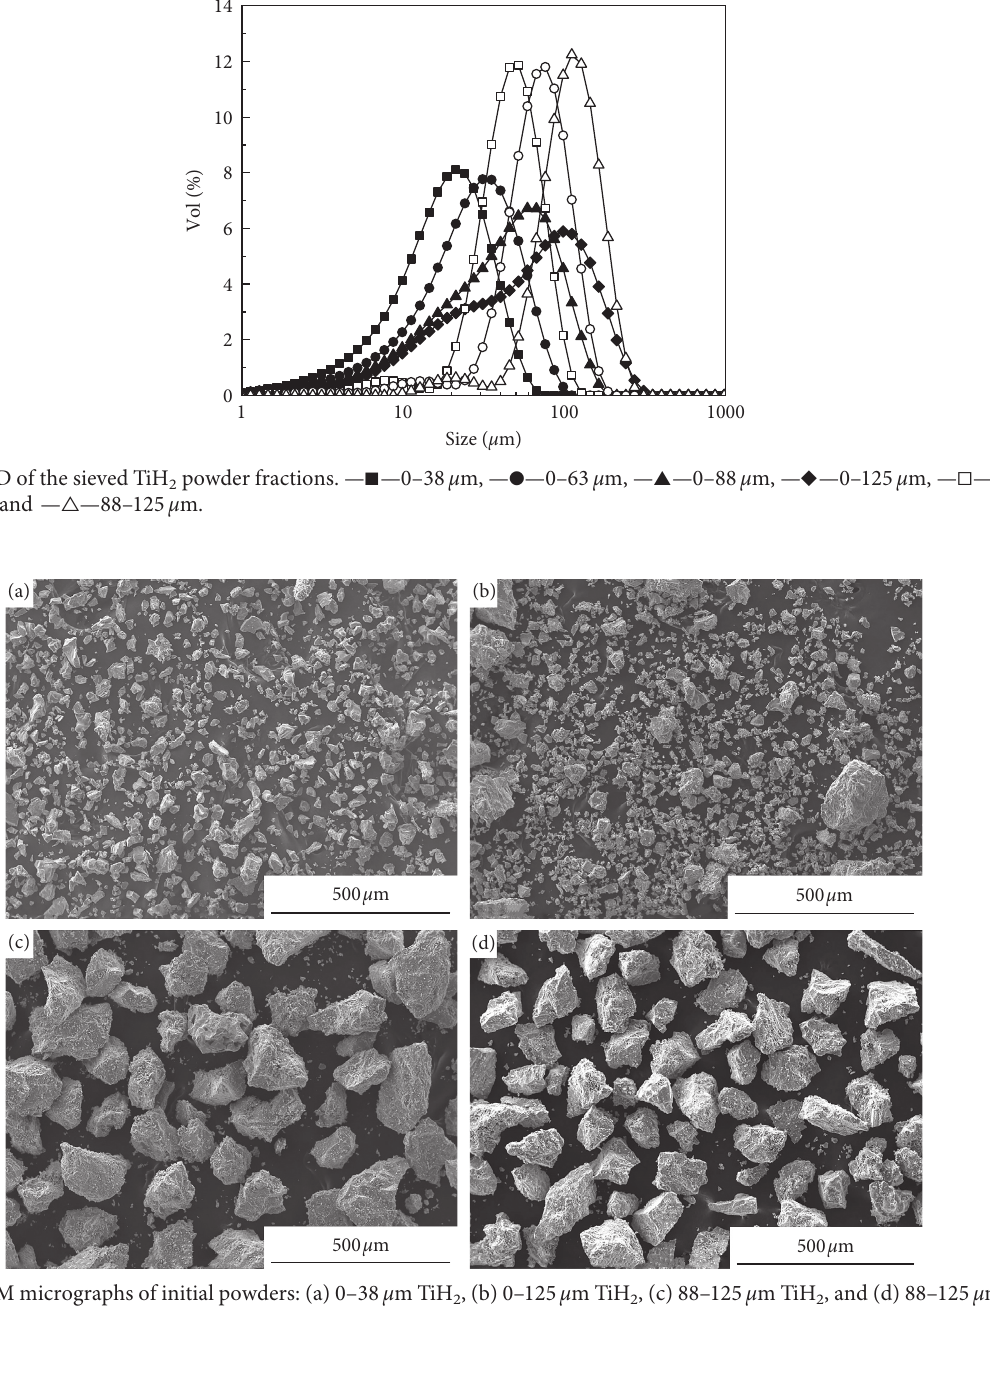
Table 1: Dv (50) and Dv (90) sizes of some starting TiH 2 powders and its change after compaction depending on pressure applied. Sieved size ( μ m) Initial size ( μ